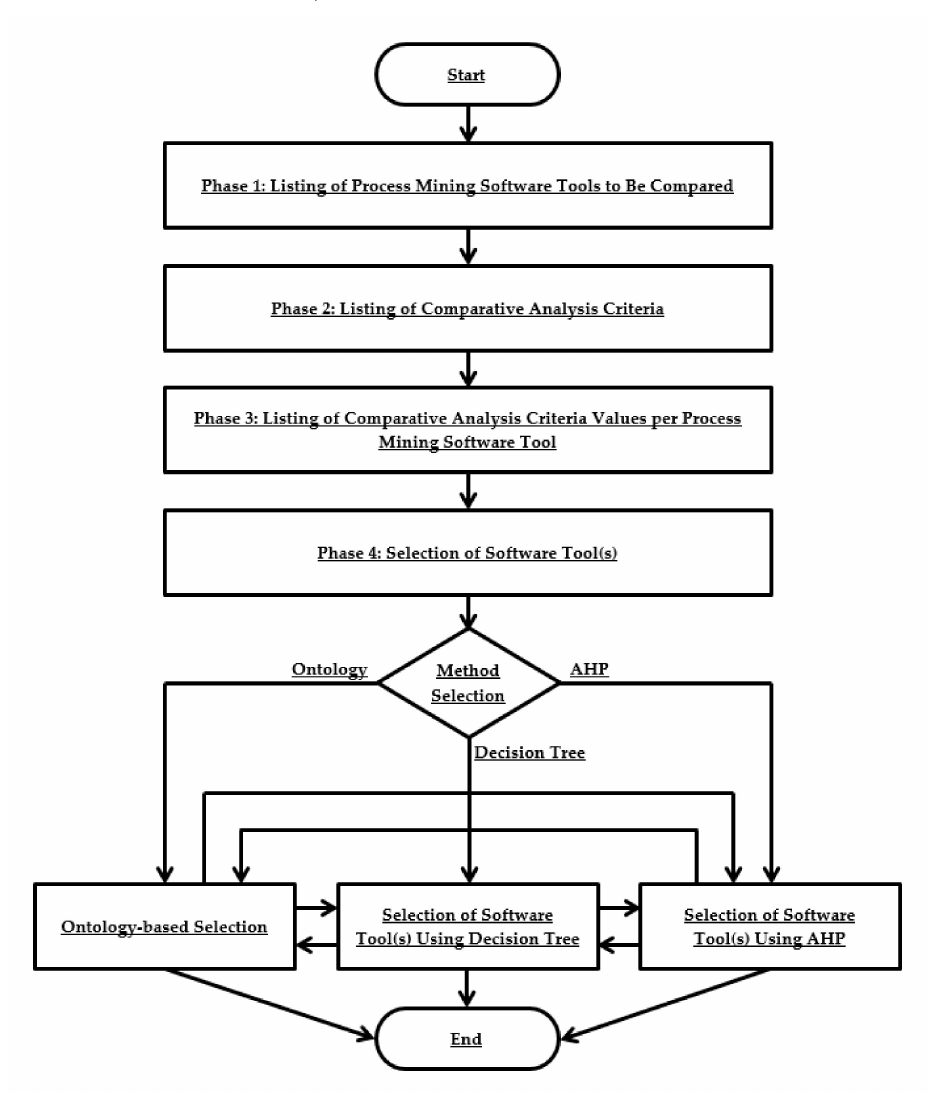
Figure 3. Comparative analysis